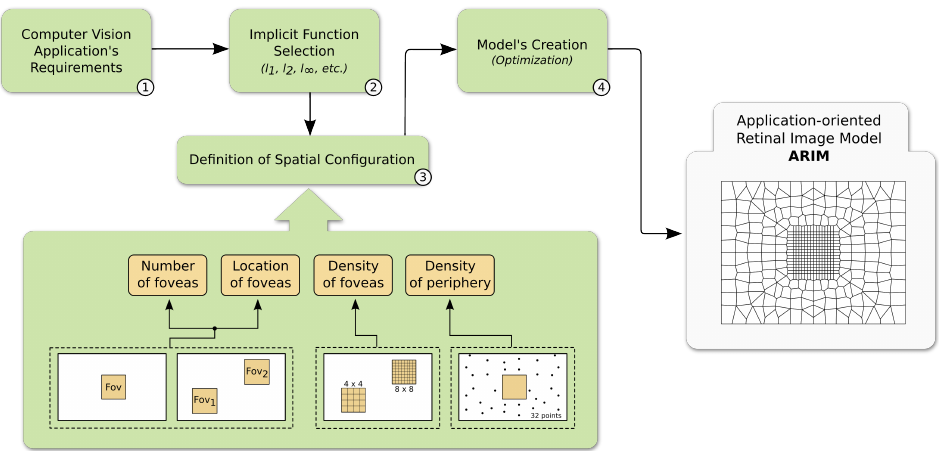
Figure 1. The proposed framework to generate application-oriented retinal image models (ARIMs).